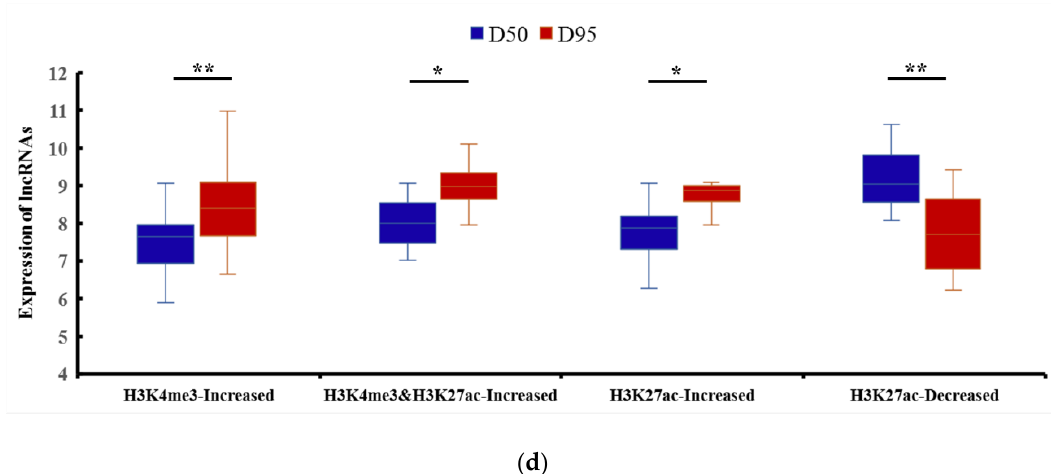
Figure 3. DElncRNAs were regulated by the H3K4me3 and H3K27ac modifications. ( A ) Quantitative real-time PCR (qRT-PCR) validation of the di ff erentially expressed lncRNAs in porcine placenta on gestational days 50 and 95. ( B ) ChIP Quantitative PCR (ChIP-qPCR) validation of the H3K4me3 and H3K27ac modifications of the di ff erentially expressed lncRNAs in porcine placenta on gestational days 50 and 95. ( C ) IGV (Integrative Genome Viewer) views of the H3K4me3 and / or H3K27ac modification patterns. ( D ) Box plots of the expression value of the lncRNAs that were modified by H3K4me3 and / or H3K27ac. Data are represented as mean + SEM, n = 3. * p < 0.05; ** p < 0.01. D50, gestational day 50; D95, gestational day 95.